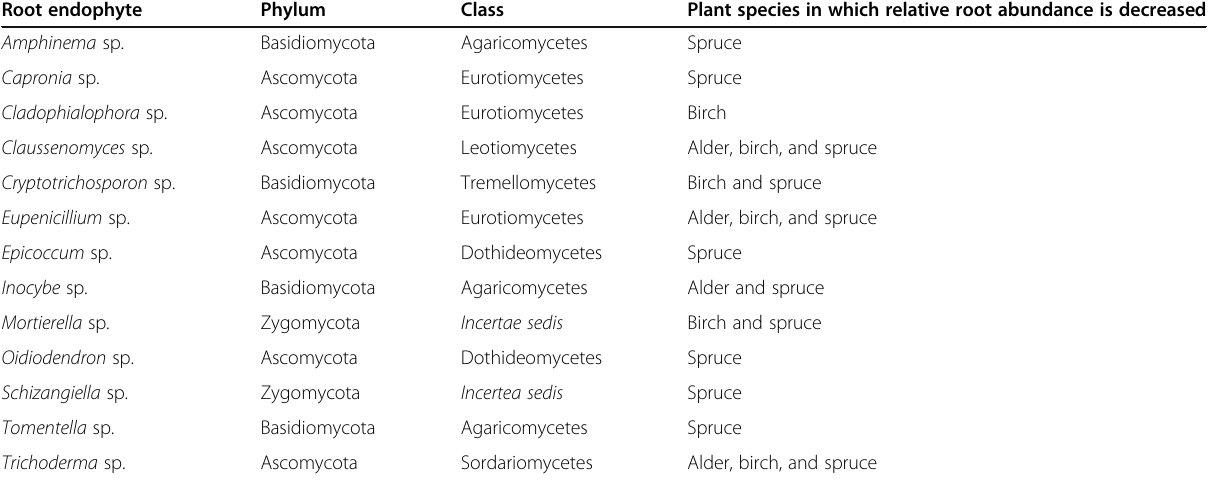
Table 3 Species found in decreased relative abundance in roots of plant species found on the mine site Root endophyte Phylum Plant species in which relative root abundance is decreased Amphinema sp.